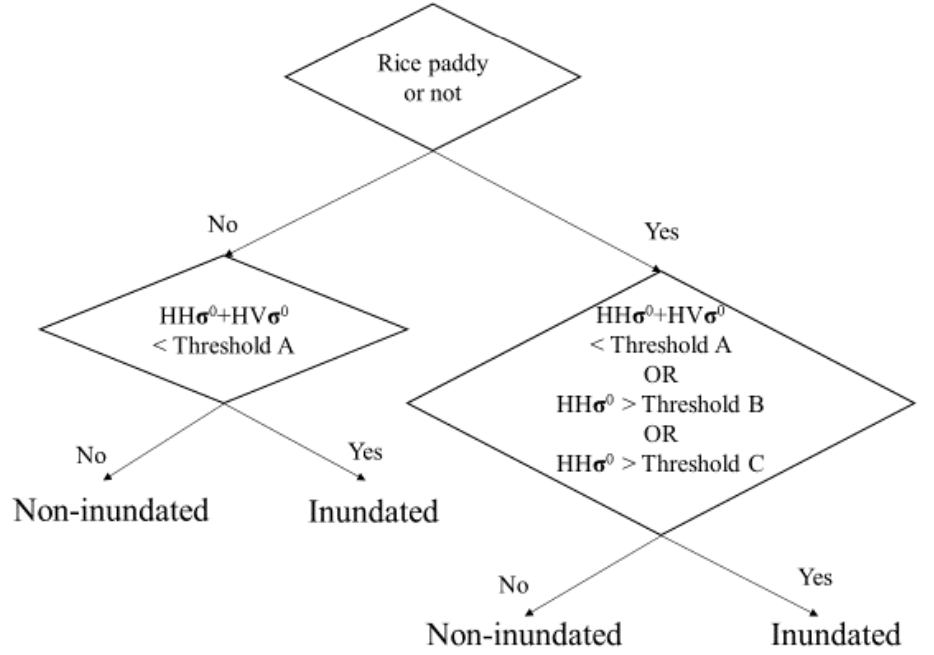
Figure 5. Algorithm of the inundated/noninundated classification.